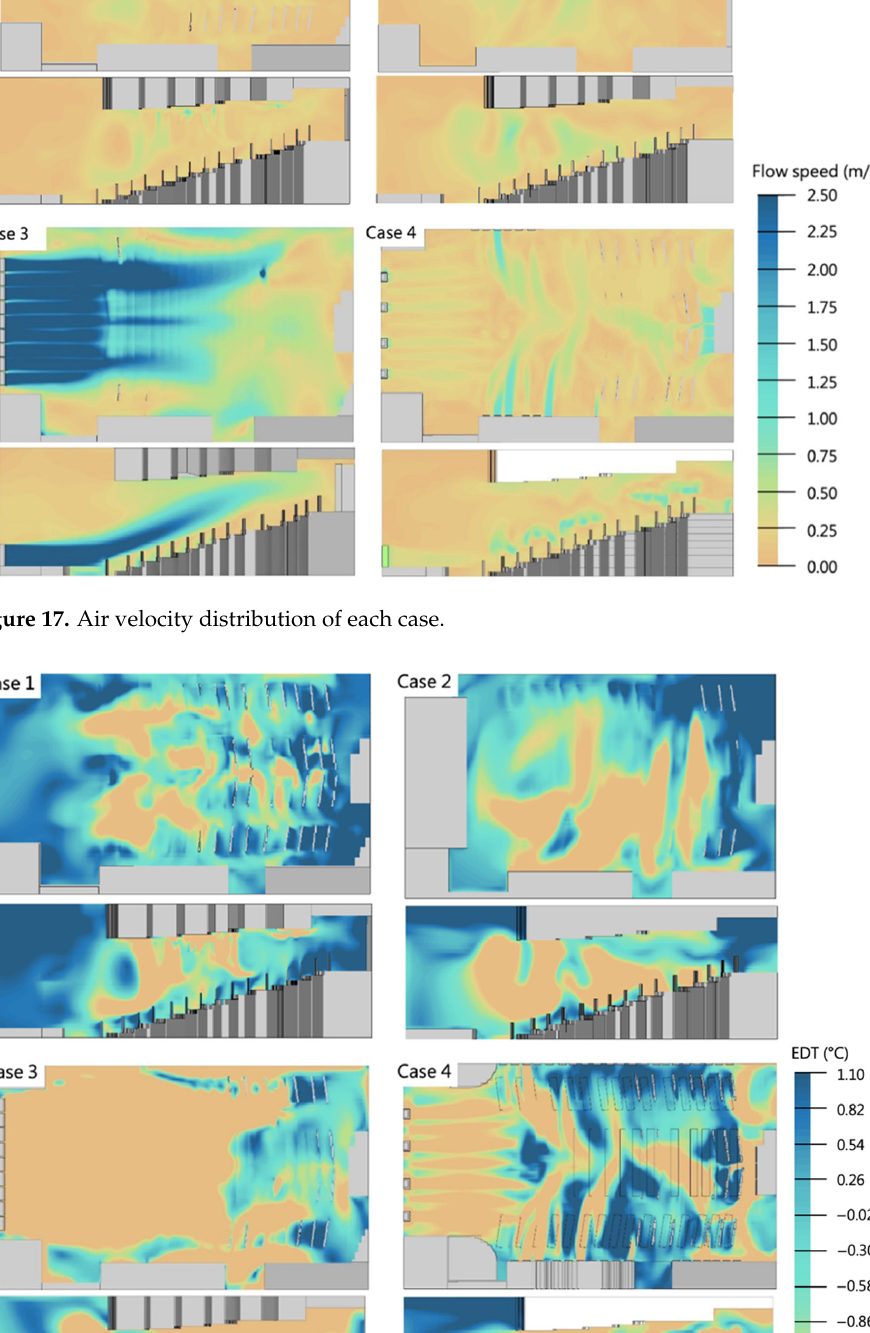
Figure 18. EDT distribution of each case.